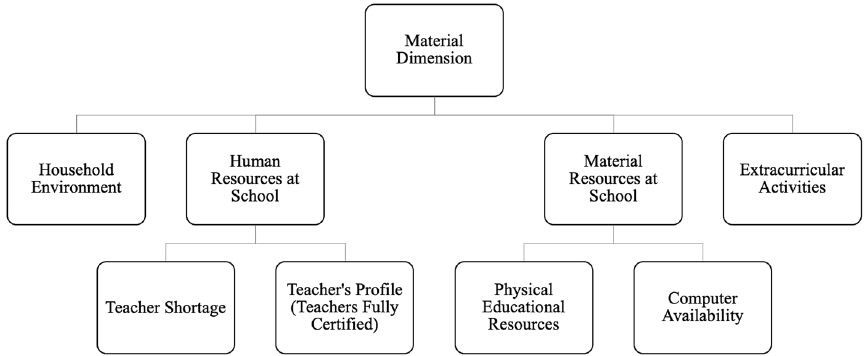
Fig. 1 Material Dimension of Well-Being. Adapted from “A Framework for the Analysis of Student Well-Being in the PISA 2015 Study: Being 15 in 2015”, by F. Borgonovi & J. Pál, 2016, OECD Education Working Papers,